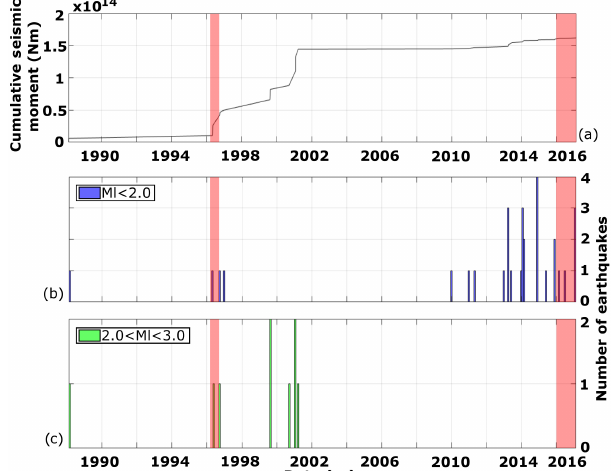
Figure 6. Seismicity of an area 10km in radius around the Prà di Lama lake. Cumulative seismic moment released in the area (a) and histograms of the number of earthquakes per month. Three different classes of magnitude have been created: M l < 2 . 0 (b) , 2 . 0 < M l < 3 . 0 (c) and M l > 3 . 0 (d) . The data set covers the period between 1986 and 2017. The red transparent bars indicate the two events of unrest of 1996 and 2016. The orange solid line in panel (a) marks the M w 4.8 earthquake, on 25 January 2013.